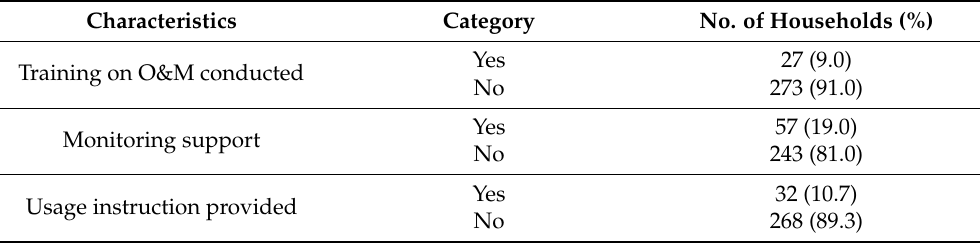
Table 6. Various surveillance activities carried out by government/NGOs.